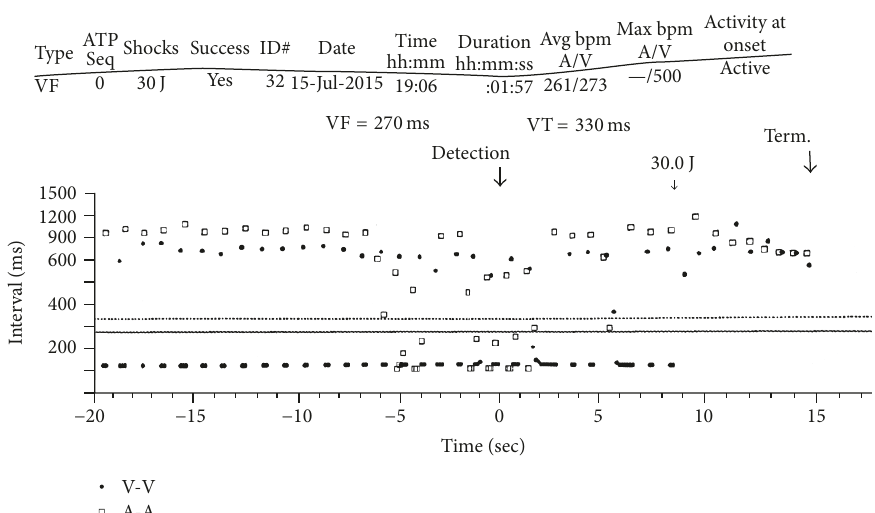
Figure 2: ICD histogram showing evidence of AC voltage current with a mean cycle length of 120 millisec requiring an electrical shock with resultant termination. This data lead to the diagnosis of alternating current (AC) interference by the ICD in proximity to the electrical generator, which was interpreted as a ventricular arrhythmia leading to inappropriate